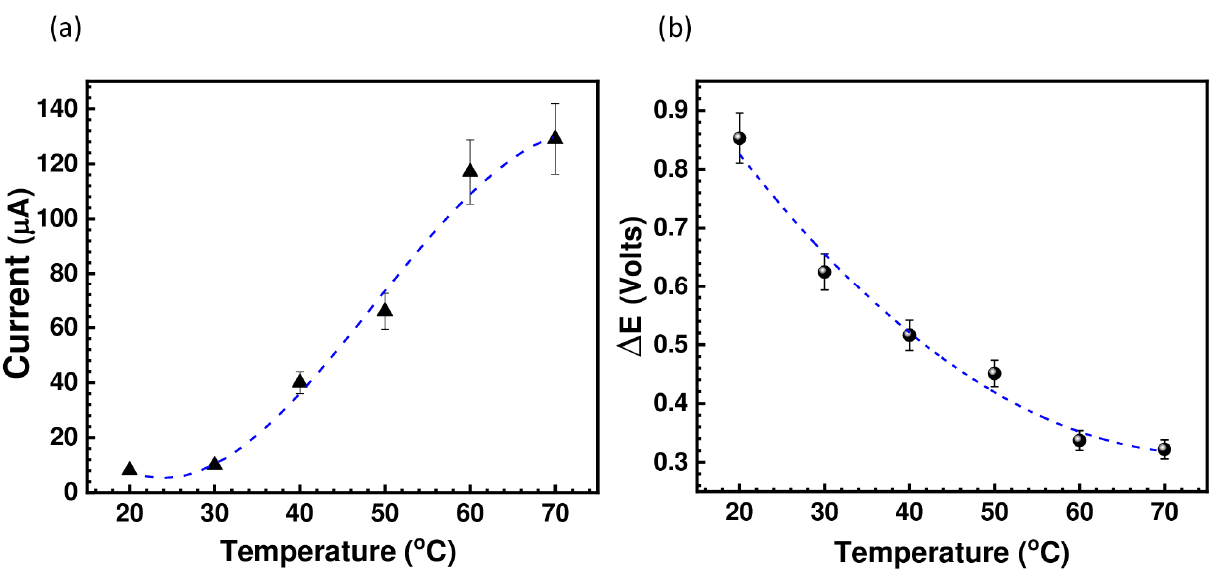
Figure 5. Variation of ( a ) the peak current as a function of the temperature, and ( b ) variation of redox potential as function of the temperature (right) for (BMIM)(HSQ).